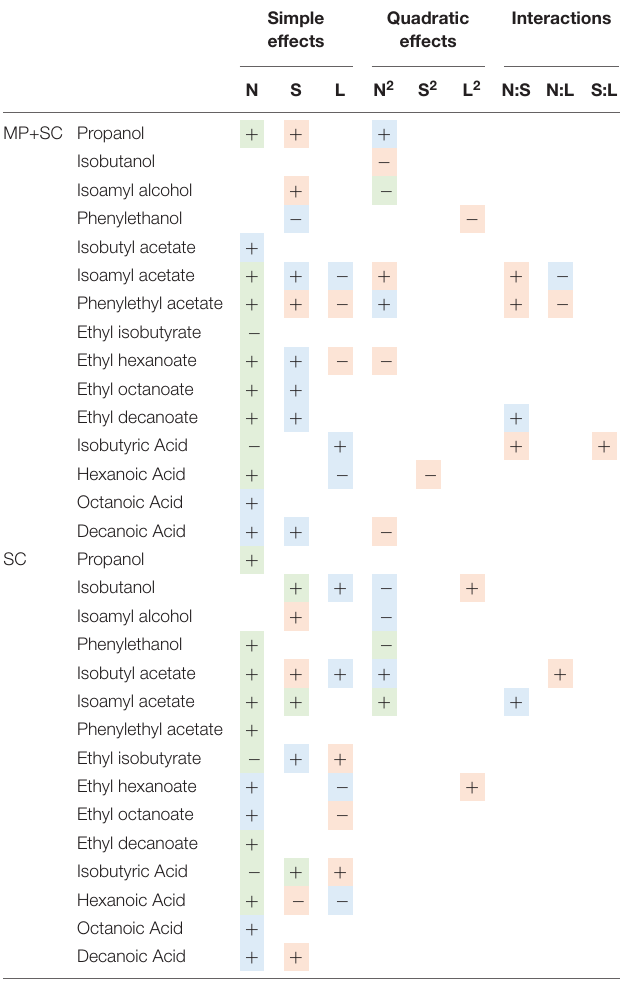
TABLE 6 | Effects of must parameters on the production of the main fermentative aromas by M. pulcherrima and S. cerevisiae under sequential inoculation (MP + SC) and S. cerevisiae in pure culture